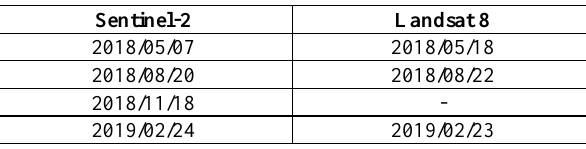
Table 1. Image sensing dates.